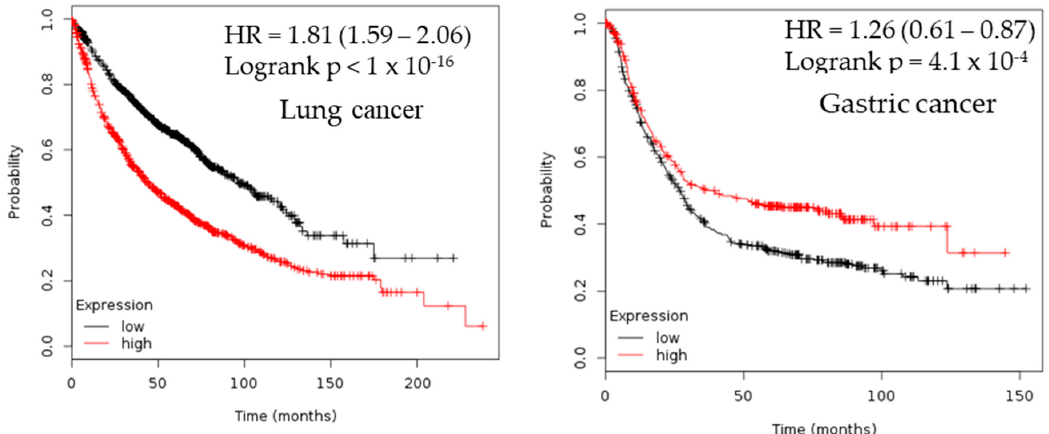
Table 2. The relationship between CHEK1 expression and survival in solid tumor clinical samples. Figure 3. Overall survival analysis of CHEK1. The survival curve comparing the patient with high and low expression in four selected solid tumors was plotted from the Kaplan–Meier plotter database.